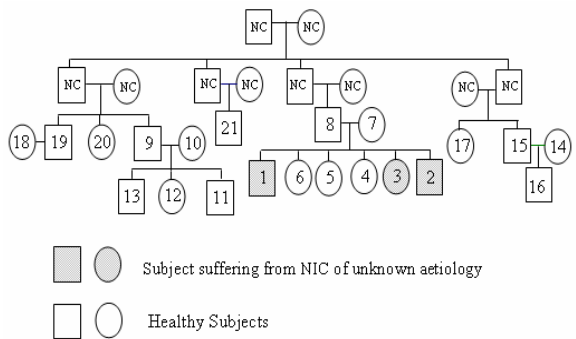
Figure 2: Genealogical tree of people included in the